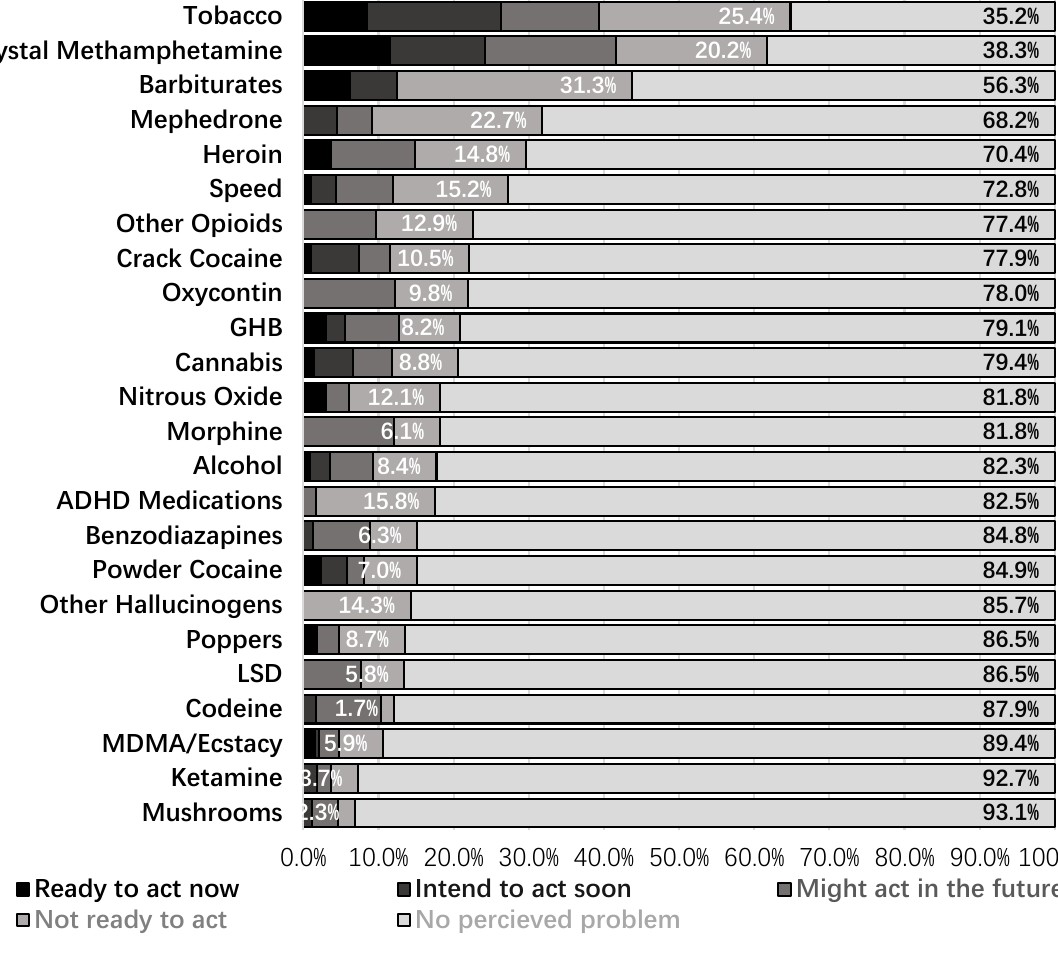
FIGURE 1. Drug-specific readiness to change among participants using each given drug. doctor’s offices (32.9%), sexual health clinics (26.8%), and other clinics